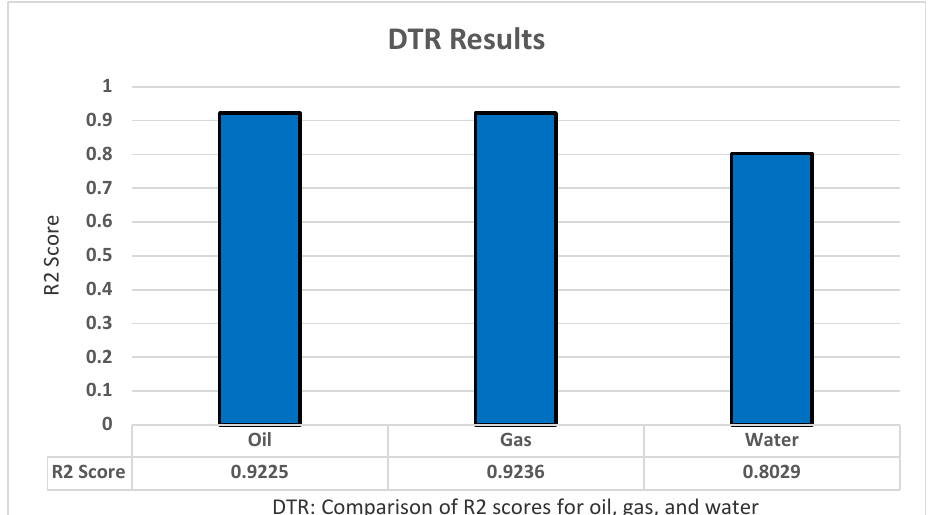
Figure 7. DTR’s R2 score results.